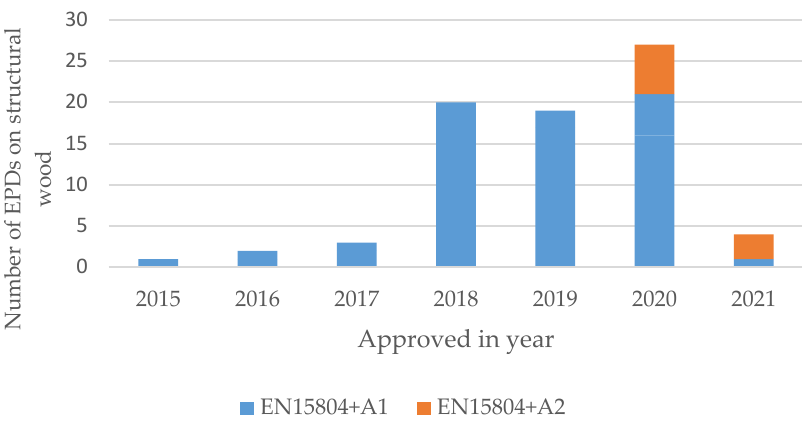
Figure 3. Number of EN 15804 EPDs and their year of approval.